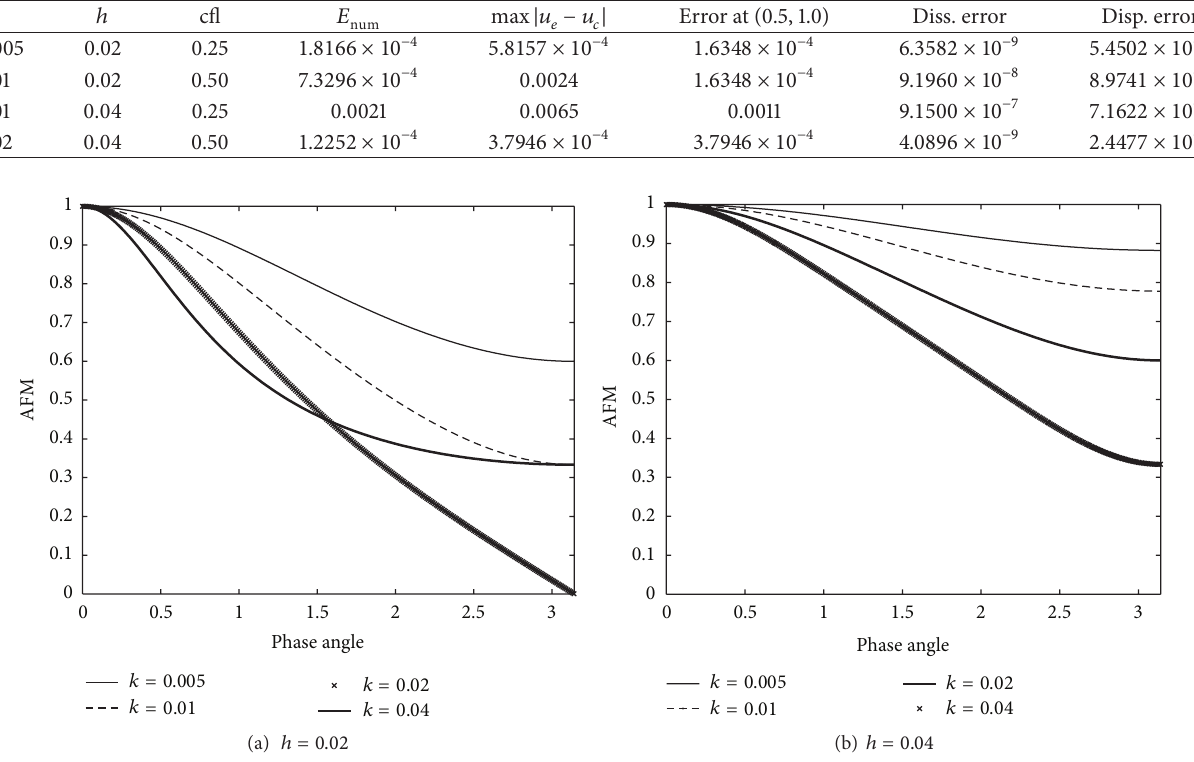
Figure 3: Plot of AFM versus phase angle for the Crank-Nicolson